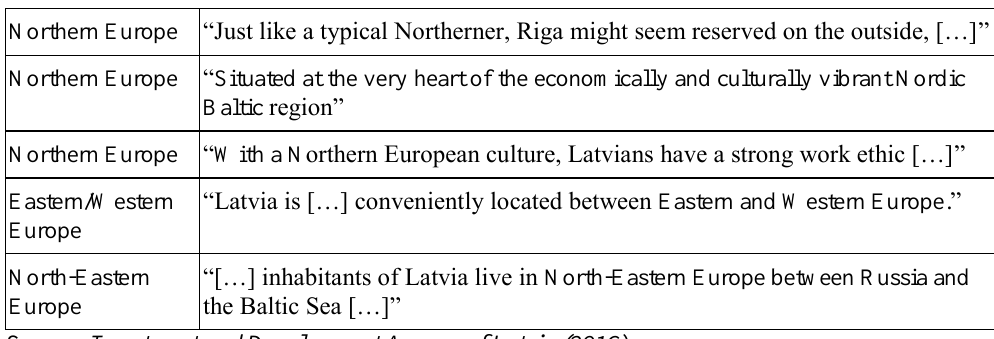
Table 2. References to Geographical Identity of Latvia